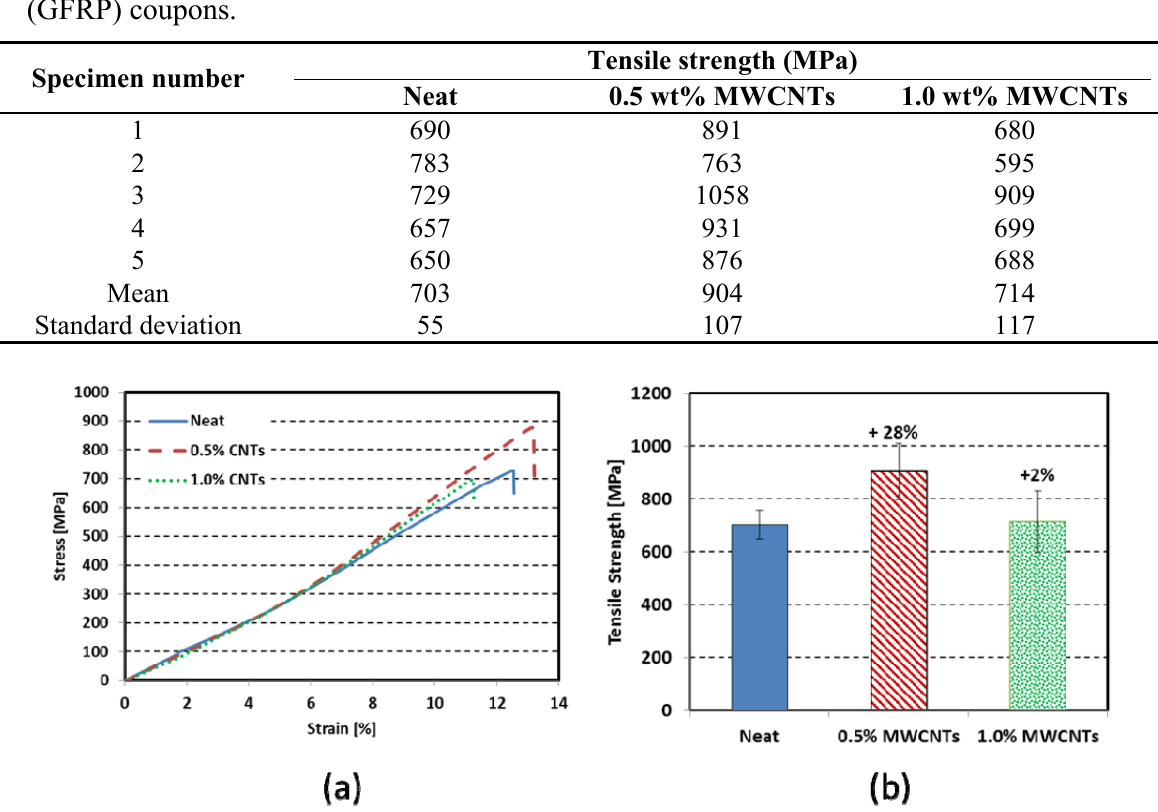
Table 1. Tensile strength (MPa) for individual Glass Fiber Reinforced Polymer (GFRP) coupons.